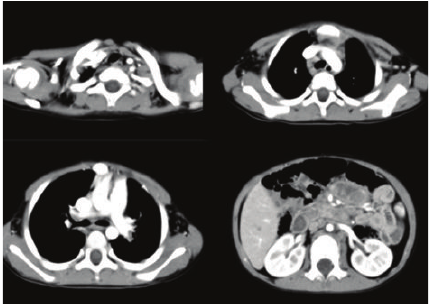
Figure 6: After five weeks of treatment, the thoracic and abdominal CT showed that the swelling of the lymph nodes was markedly